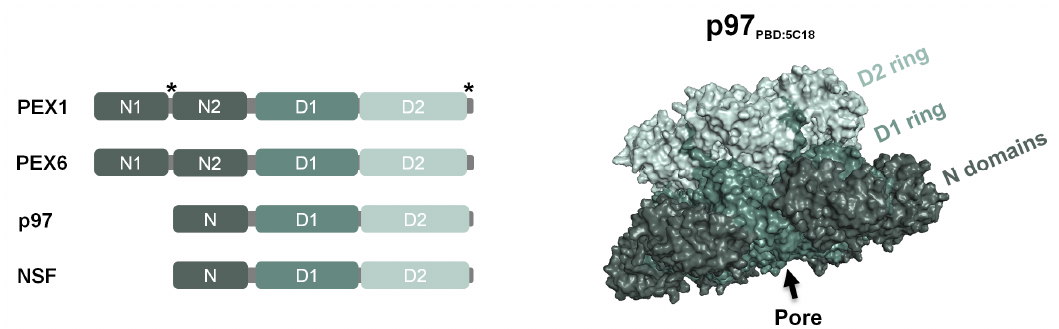
Figure 2. Domain architecture of the type II AAA + proteins PEX1, PEX6, p97 and NSF. The two N-domains of PEX1 and PEX6 (N1 and N2) homologous to the N-domain of p97 and NSF (N-domain), and the two AAA + domains (D1 and D2) are shown (left). Note that mammalian PEX1 is longer than the yeast protein, possessing a di ff erent spacing between its N-domains, it also has an extended C-terminal tail after the D2 domain (marked with asterisks). Atomic model of a p97 hexamer (right; PDB code 5C18, [138]) showing the common type II AAA + structure consisting of one ring of D1 domains on top of another ring of D2 domains, and the six N-domains located on the side of the D1 ring. Note that this p97 structure was obtained in the presence of a non-hydrolysable ATP analogue and in the absence of substrate